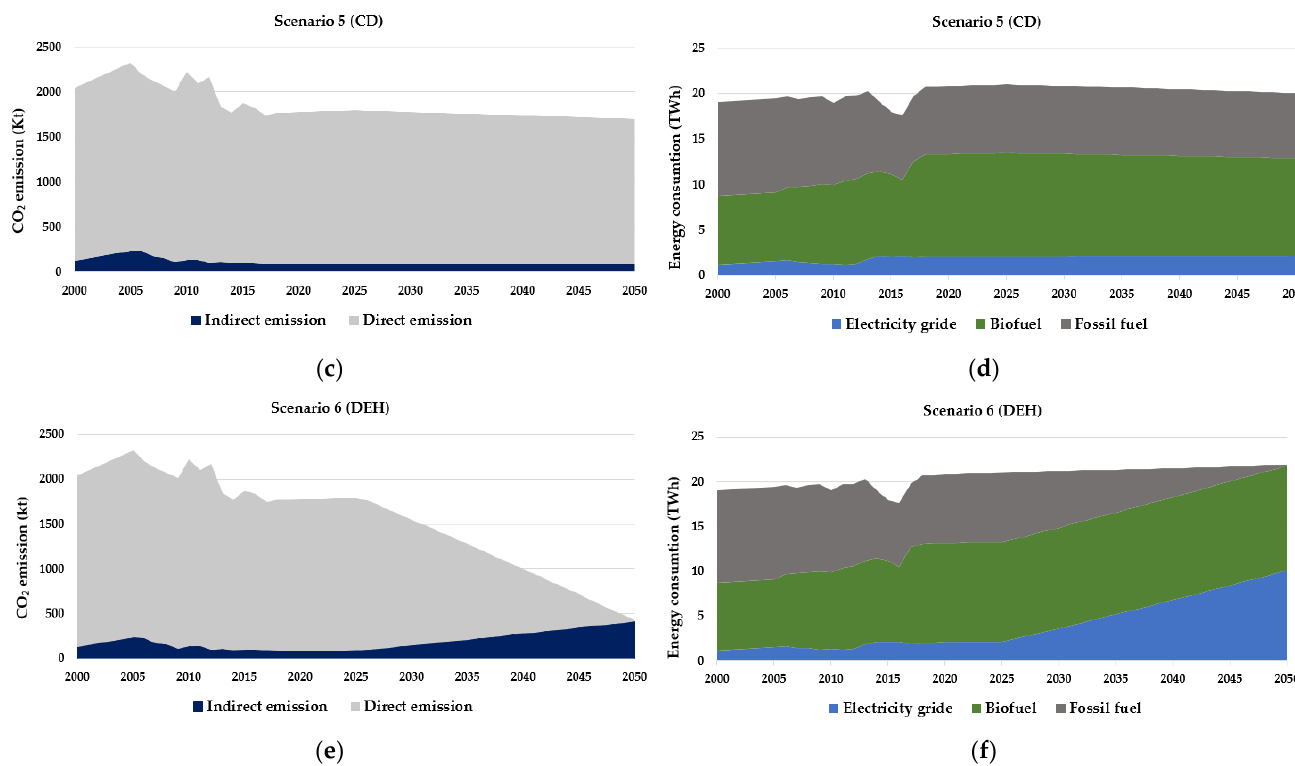
Figure 12. Projection of emission reduction and energy consumption according to three selected scenarios: ( a ) estimation of CO 2 emissions due to the application of dry sheet forming (DSF) up to the year 2050; ( b ) estimation of energy consumption due to application of dry sheet forming (DSF) up to the year 2050; ( c ) estimation of CO 2 emissions due to the application of condebelt drying (CD) up to the year 2050; ( d ) estimation of energy consumption due to application of condebelt drying (CD) up to the year 2050; ( e ) estimation of CO 2 emissions due to the application of direct electric heating (DEH) up to the year 2050; ( f ) estimation of energy consumption due to the application of direct electric heating (DEH) up to the year 2050.